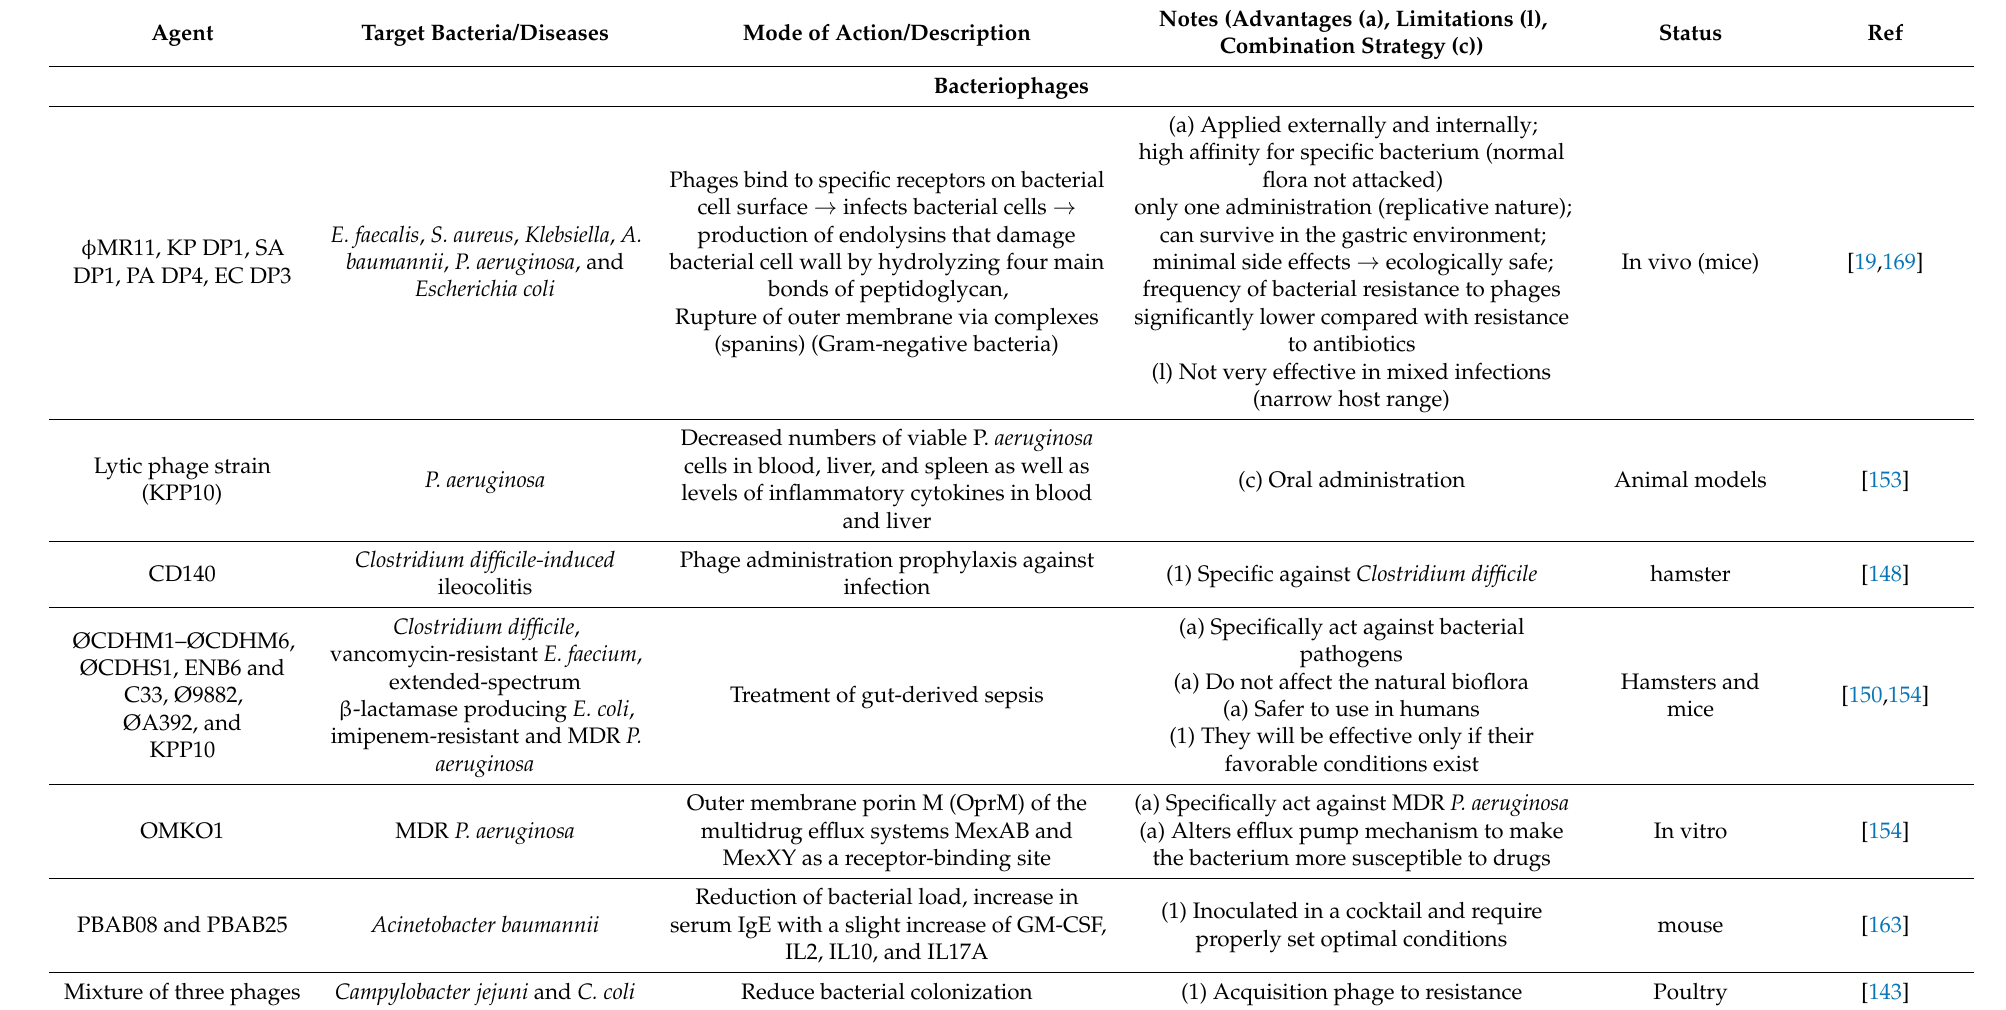
Table 4. Bacteriophages as a therapeutic option against